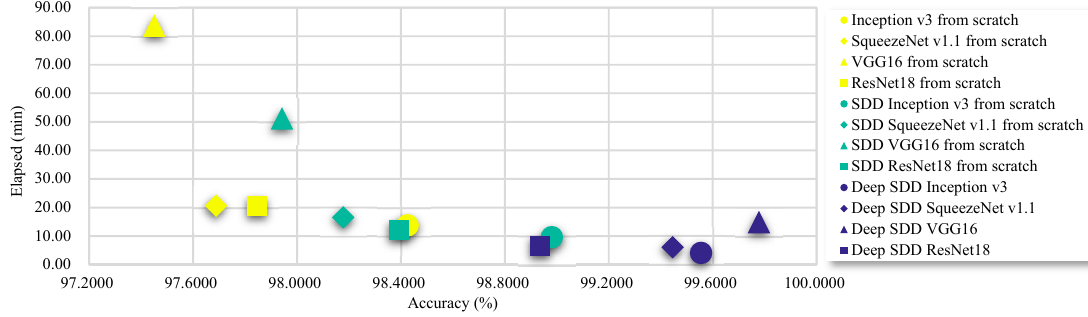
Figure 9. Diagram of convergence time and validation accuracy.